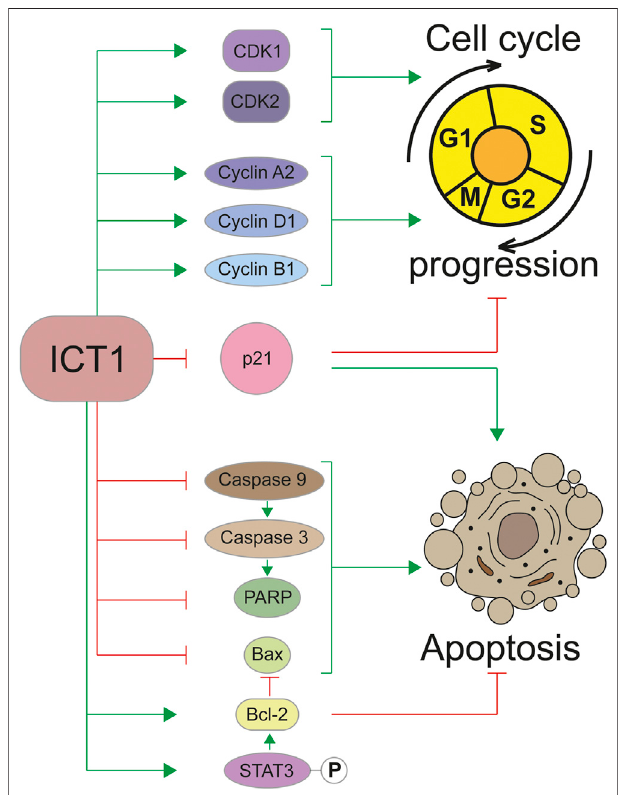
FIGURE 2 | Regulation of the cell cycle and apoptosis by the ICT1 protein. Green arrowheads mean a promotion, red fl atheads mean an inhibition. P in a circle represents a phosphate